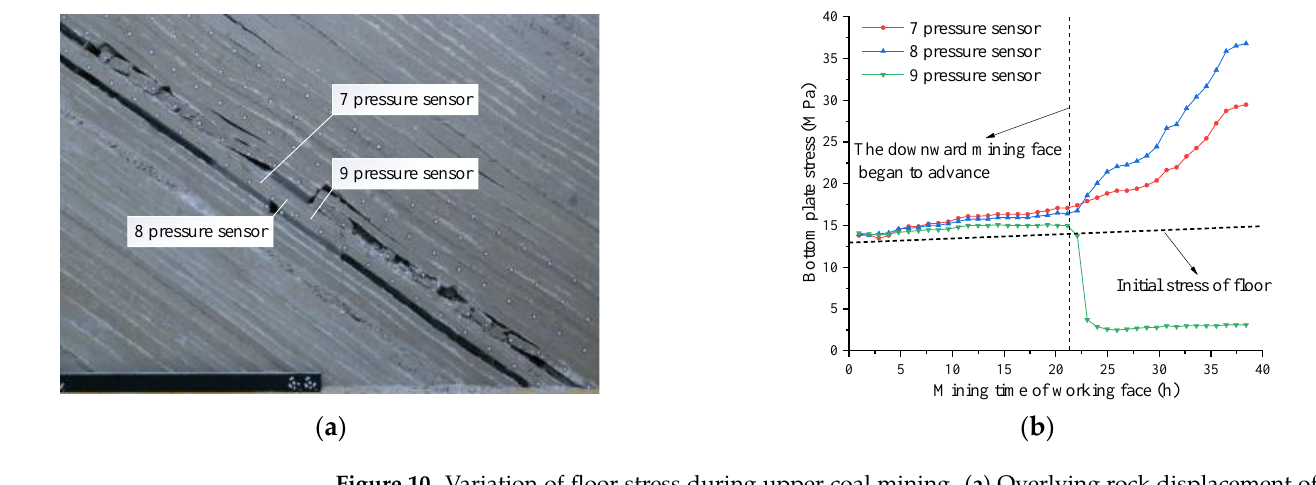
( b ) Figure 9. Stress distribution of top mining floor. ( a ) Mining 75 m in the top mining face; ( b ) stress diagram of top mining floor. 5.3. Distribution Characteristics of Floor Stress After the upper coal was recovered, some radial fractures in the upper layer of the